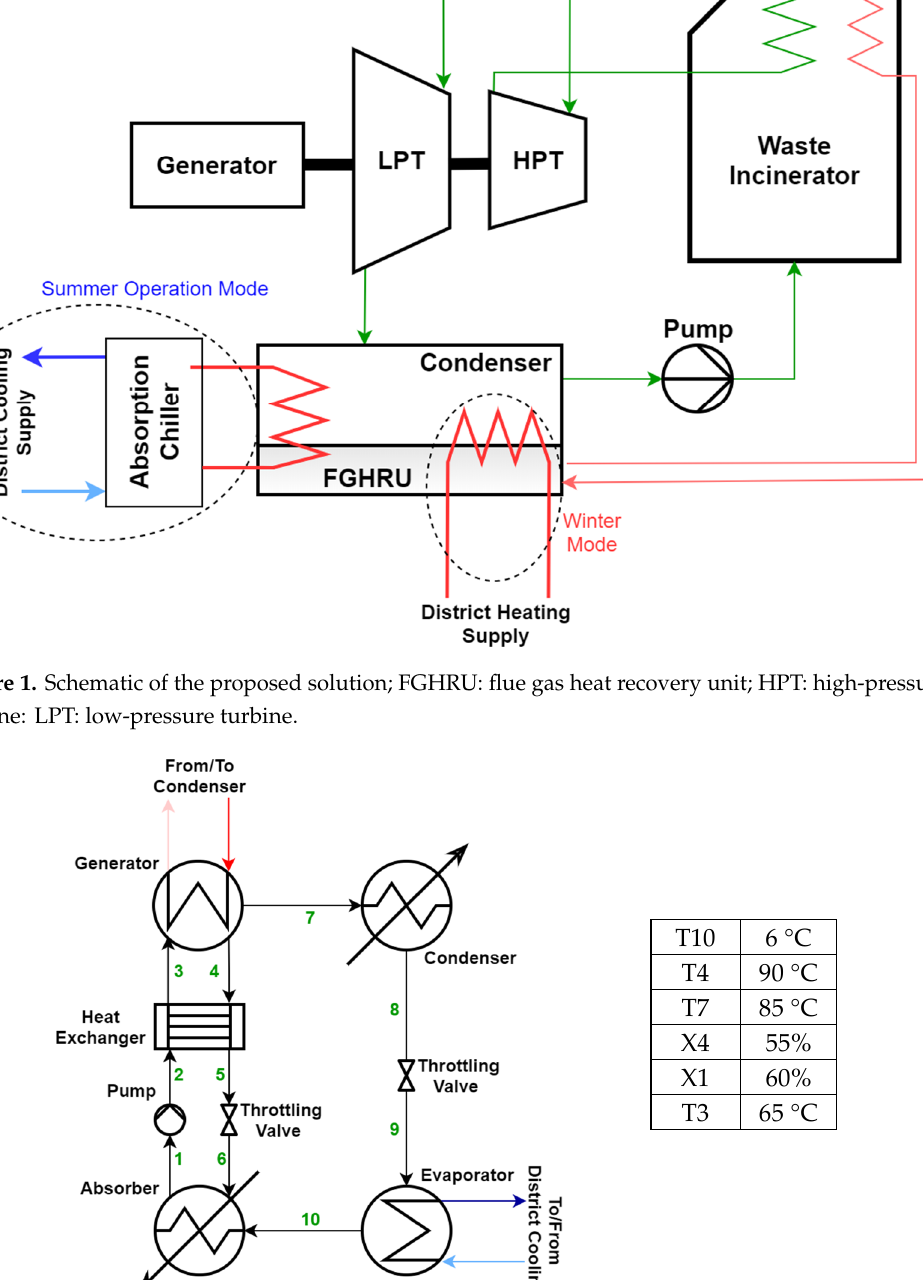
Figure 2. The schematic of the LiBr-water chiller and its operating characteristics; T: temperature, X: concentration of the solution (the mixture of